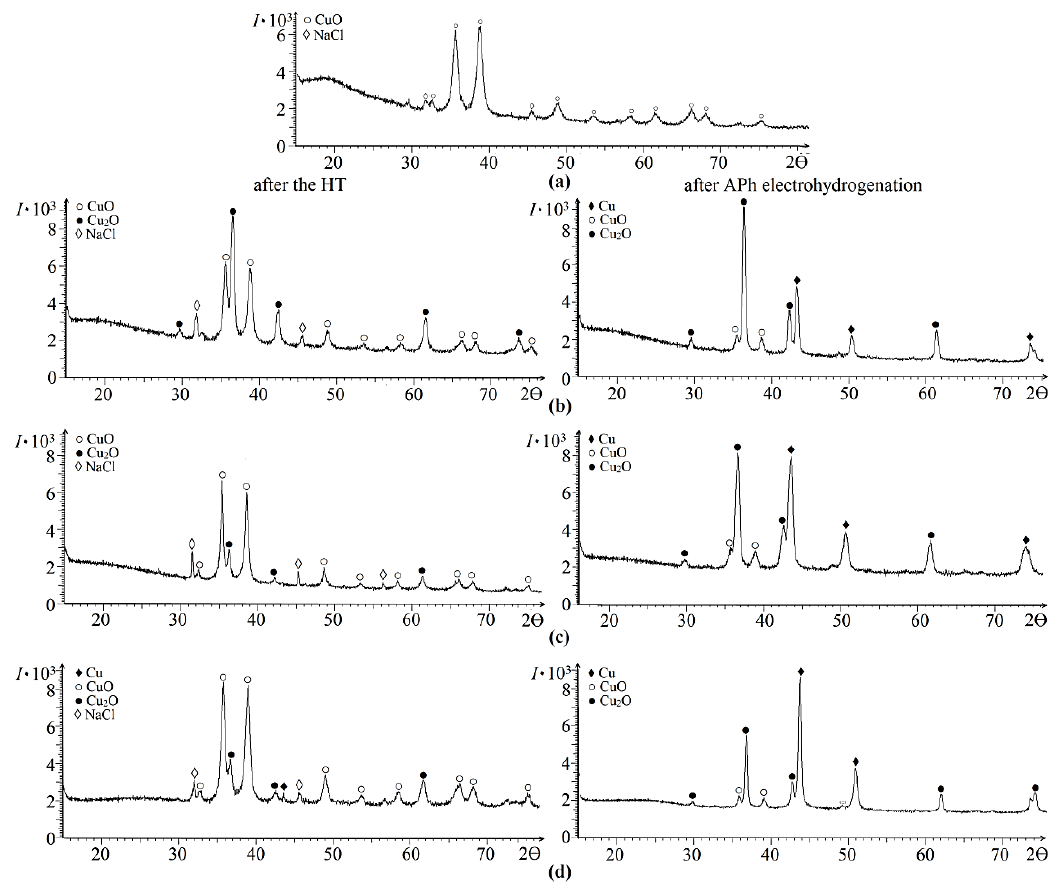
Figure 3. XRD patterns of AFP + Cu(NO 3 ) 2 composites ( a ) before HT and heat treated at ( b ) 400 ° С , ( c ) 500 ° С and ( d ) 700 ° С .